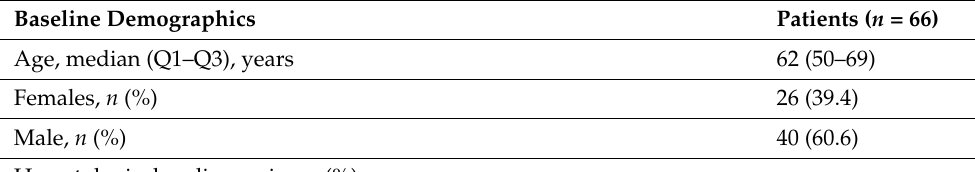
Table 1. Baseline characteristics of the